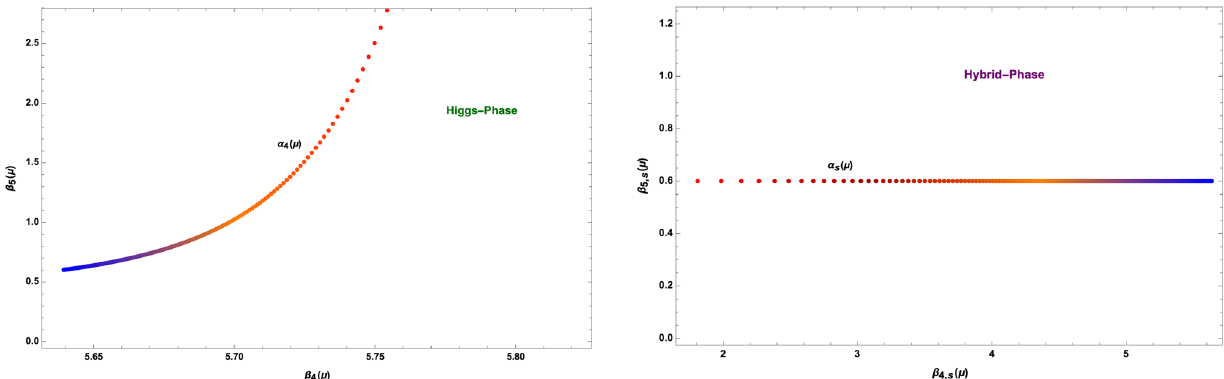
Fig. 8 The RG flow of the running coupling α 4 (μ) in the Higgs phase (left) and α s (μ) in the hybrid phase (right) depicted on the β 4 − β 5 and − β β 4 , s 5 , s plane respectively. For the latter the only running parameter is β 4 , s (μ) while β 5 , s (μ) is kept fixed at 0 . 6. The colouring of the curves